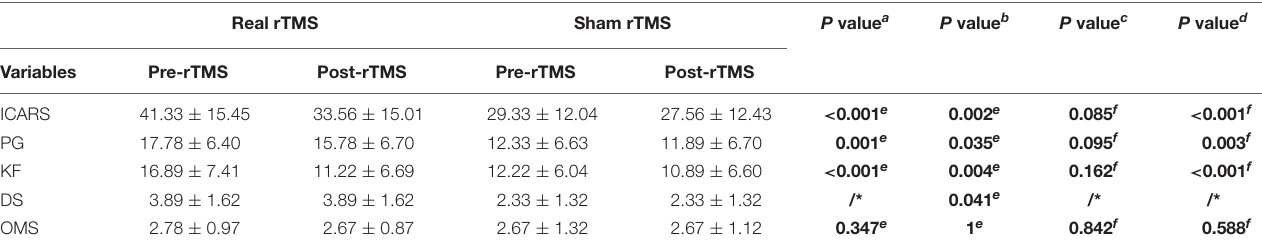
TABLE 2 | The comparison of scores of ICARS and its four subscales’ domain before and after stimulation in the real and sham intervention